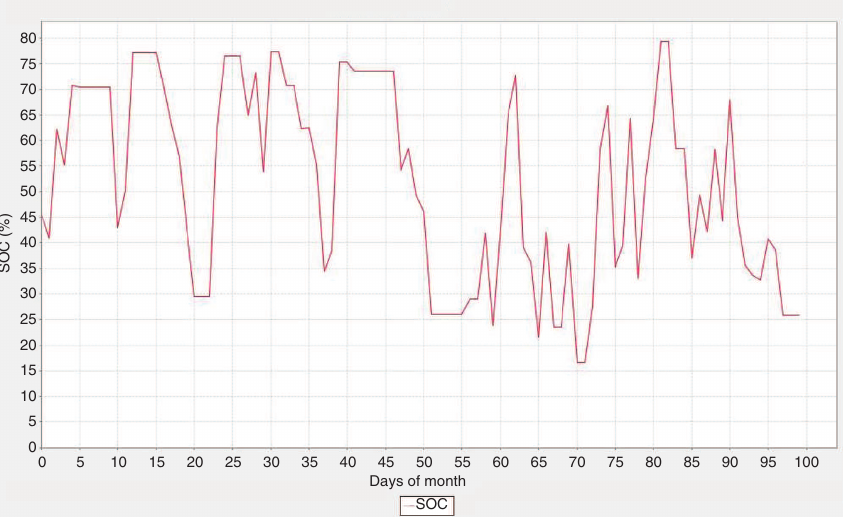
Figure 16: SOC of Batteries during the Period